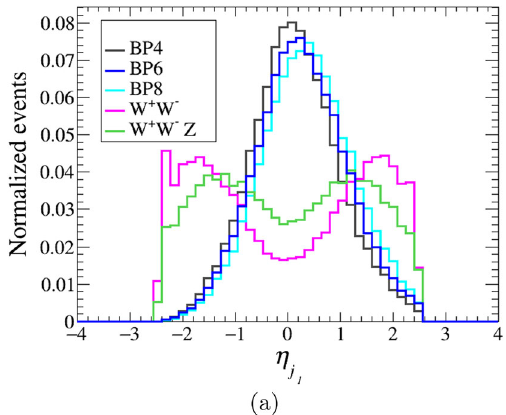
Fig. 8 Normalized distributions of the kinematic variables a η j signal and SM background) for 1 l + 2 j + E T / channel at 14 TeV muon collider